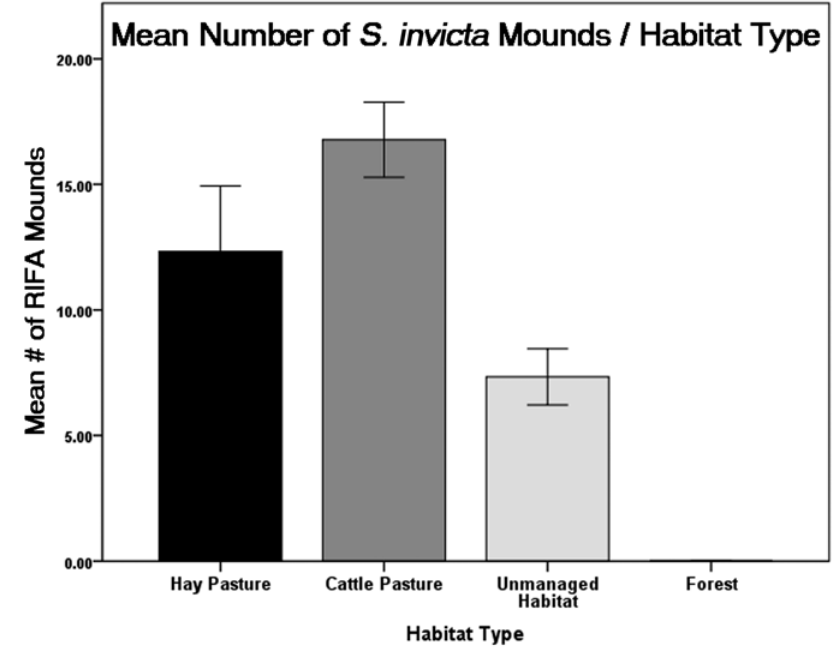
Fig. 2. Mean # of RIFA mounds in all habitat types. Mound densities were significantly higher in cattle pastures than in unmanaged habitat and forest, but were there was no significant mound density difference between cattle and hay pastures. Mound densities were significantly lower in forest than any other habitat